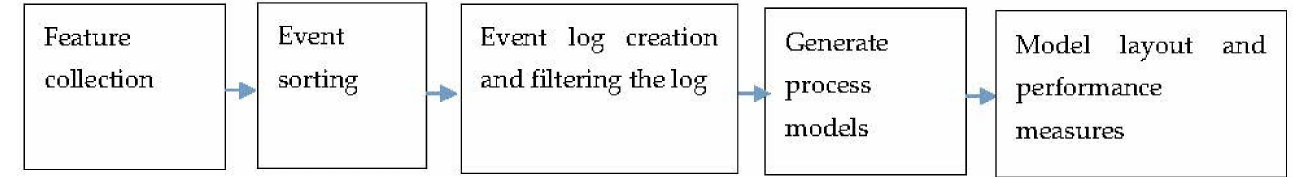
Figure 5. The architecture of an inductive visual